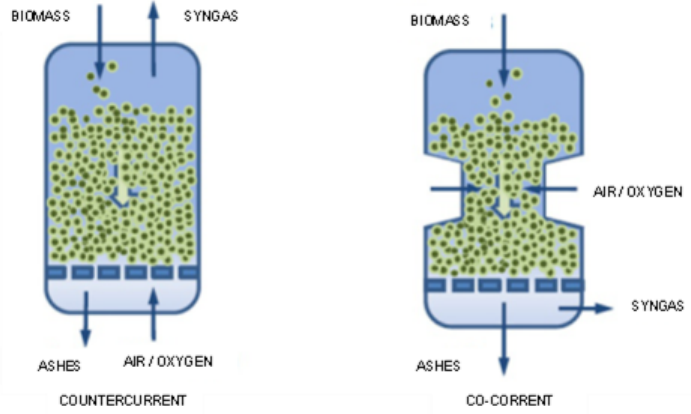
Figure 1. Fixed-bed gasifiers ([12], 2020, adapted by the